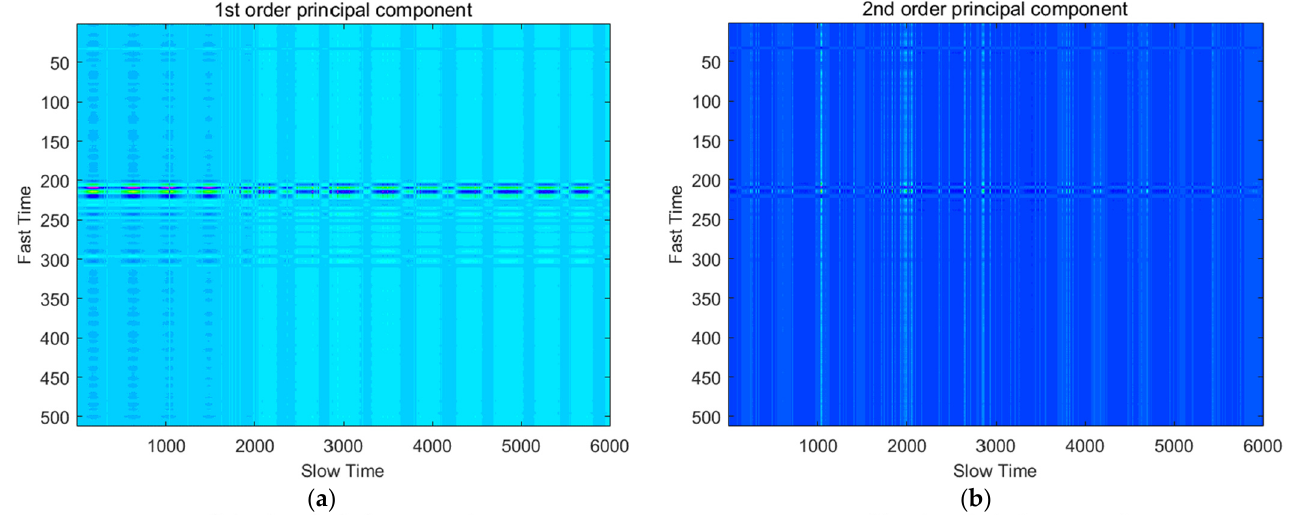
ratio from the original data will cause little loss to the effective components, and at the same time, parts of the noise with relatively large proportions are removed. Figure 8 shows the signal time domain characteristics of the first six order principal components of the radar matrix X N×M .